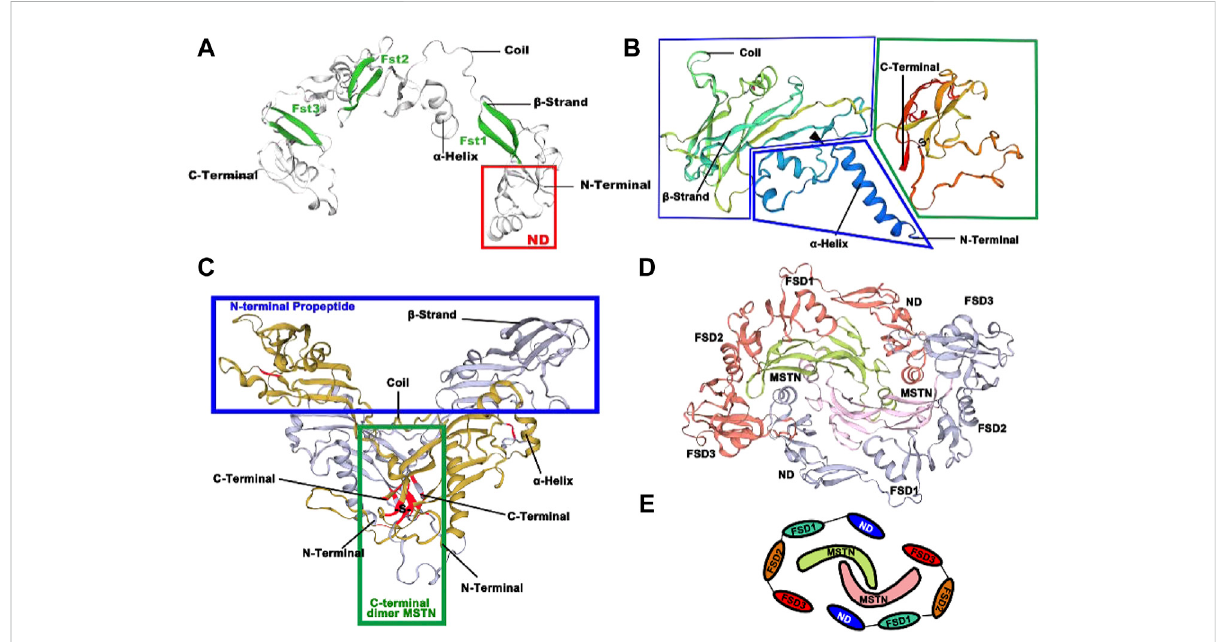
FIGURE 5 Three-dimensionstructuresofFSTandMSTNin O.potamophila . (A) Predicted 3DproteinstructureoftranscriptionfactorFST. (B) Predicted3D protein structure of MSTN. (C) Predicted 3D protein structure of the MSTN homodimer. (D) Predicted 3D protein structure of the MSTN homodimer and the FST homodimer. (E) Schematic representation of the antagonistic relationship between MSTN and